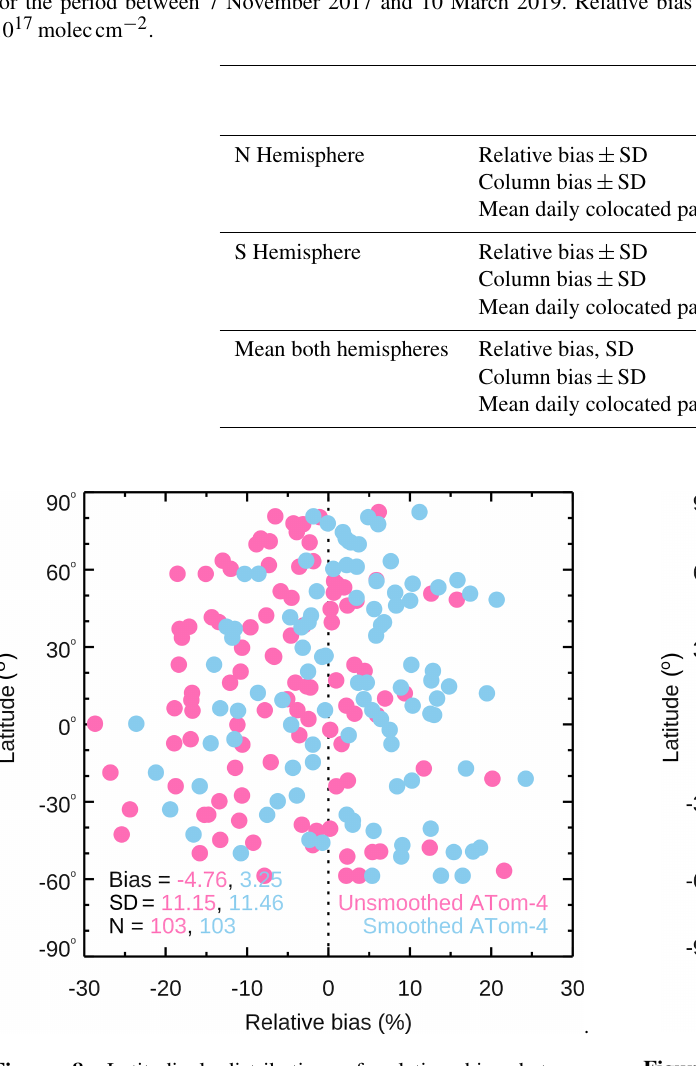
Figure 8. Latitudinal distribution of relative bias between TROPOMI and ATom-4 over bodies of water. Negative bias indi- cates that TROPOMI retrievals are low with respect to ATom-4